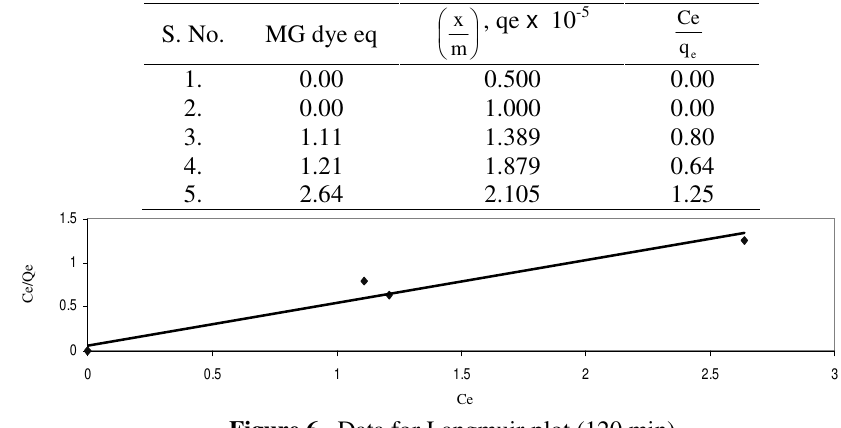
Table 6 . Data for Langmuir plot (120 min)